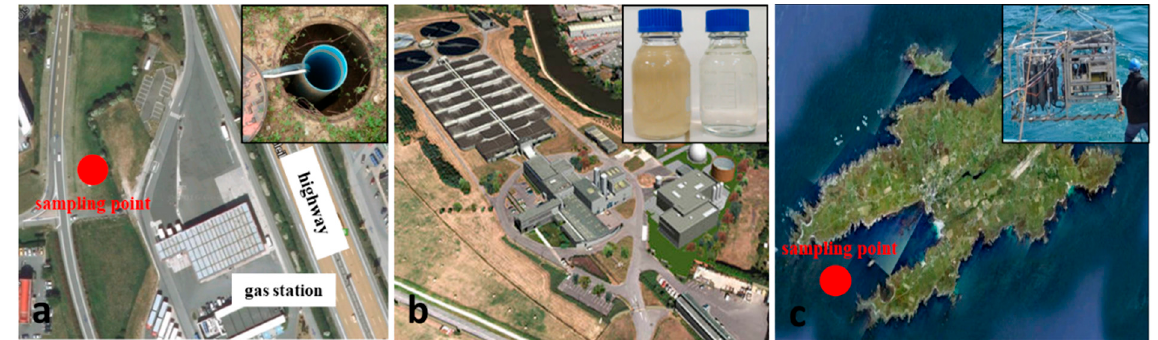
Figure 3. Water sampling sites. ( a ) Groundwater polluted by hydrocarbons near a gas station and a highway (south of Paris, France)—Inset shows the piezometer from which water was sampled; ( b ) wastewater treatment plant (Rennes, France)—Inset shows water samples from the input (left) and output (right) stations; ( c ) seawater sampled off the coast of Ushant Island (France) above the Peter Sif wreck—Inset shows profiler used to sample water.